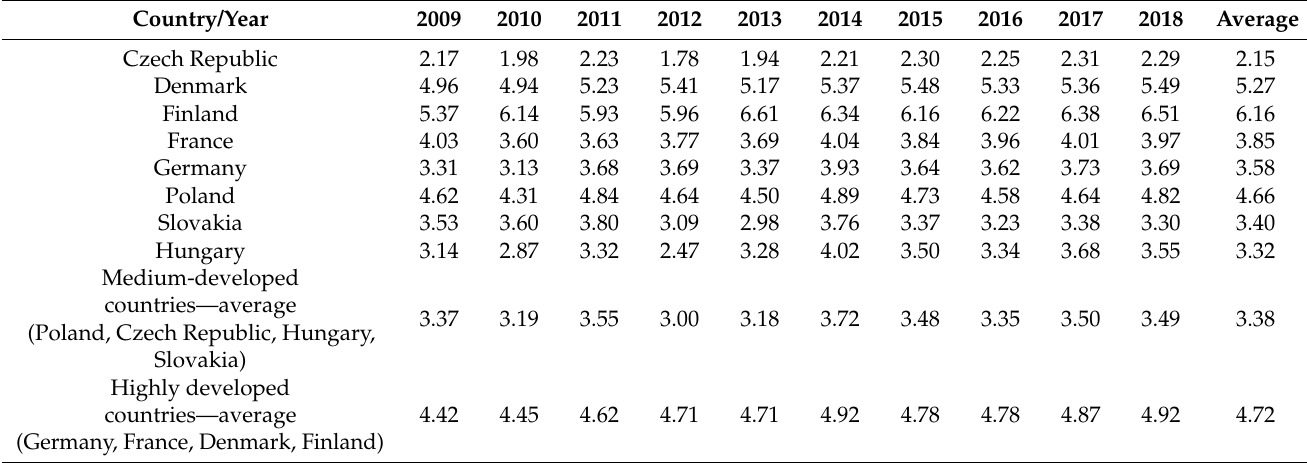
Table 5. Biomass consumption per capita in the surveyed EU countries (thousand tonnes per 1000 inhabitants). Country/Year